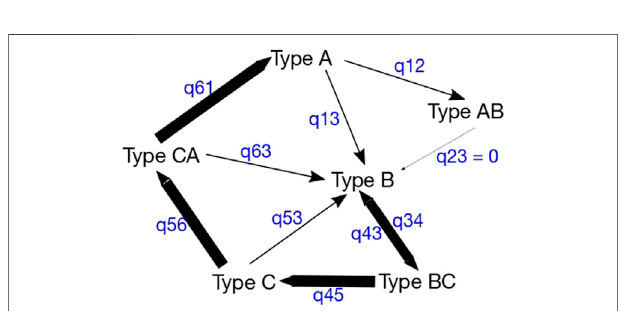
FIGURE 11 | The most frequent posterior transition rate parameter settings for the NEC + ALL_B model, attested in 594/1,000 posterior models. q23,AB > Bisexcludedfromthemodel.Therearetworates,aslow(0.39)and a fast (3.58) rate, marked by edge width.